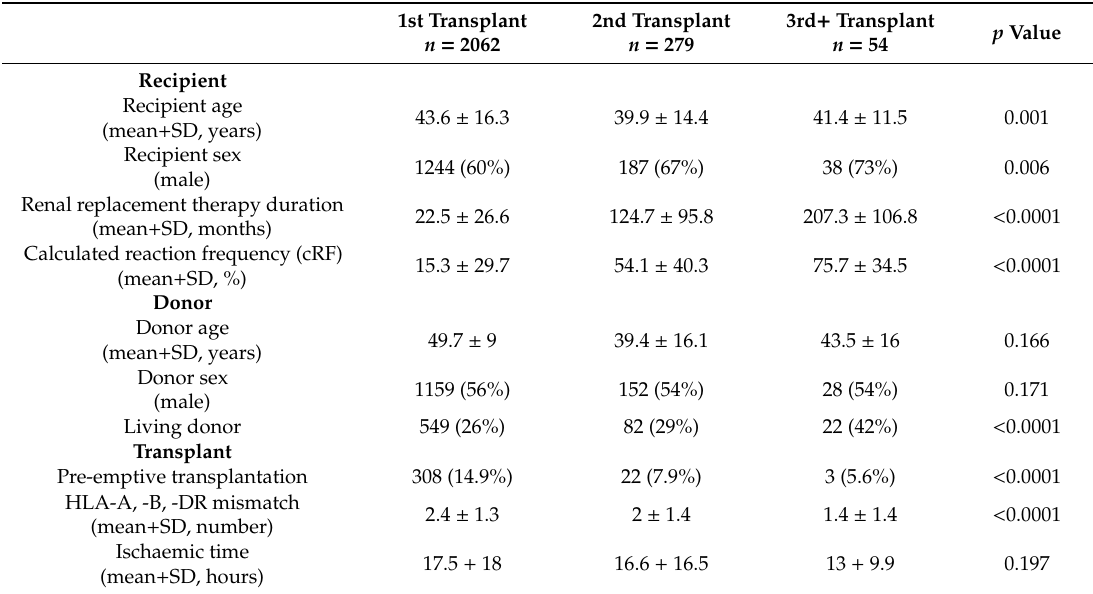
Table 1 summarises donor and recipient characteristics. Recipients of 3rd + kidney transplants were significantly more likely to receive a living donor kidney ( p < 0.0001). Table 1. Demographics of kidney transplants performed in Northern Ireland in the period